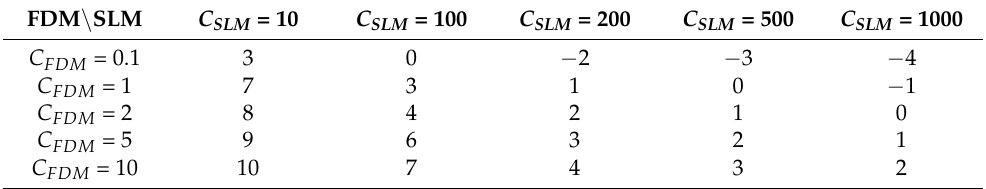
Table 7. Difference between SLM and FDM entropies for the cases of temperature. A positive value means that, for that specific combination of important steps C , SLM is more complex. A negative value means that FDM is more